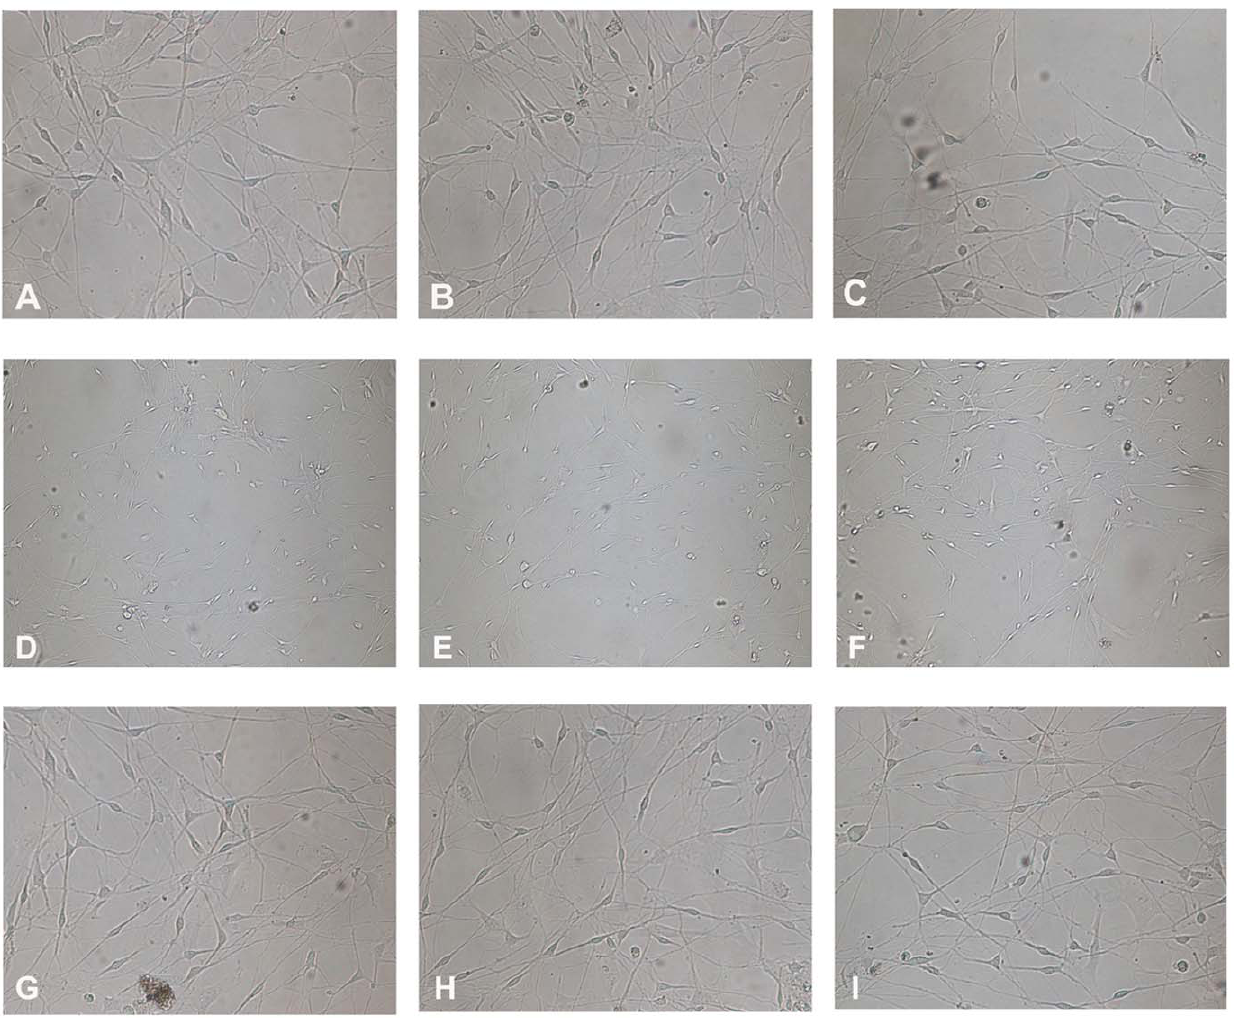
Figure 3. Effects of mechanical pressure on the morphology of DRG neurons. The sham control cells (A–C) displayed normal morphology. Cells subjected to 0.5 MPa of pressure for 30 min showed collapsed axons and other signs of necrosis after (D) 8 h, (E) 24 h, and (F) 48 h. Other cells were subjected to 0.5 MPa of pressure and treated with PD150606 for (G) 8 h, (H) 24 h, and (I) 48 h; these cells showed alleviation of pressure- induced morphological changes. All experiments were repeated at least three